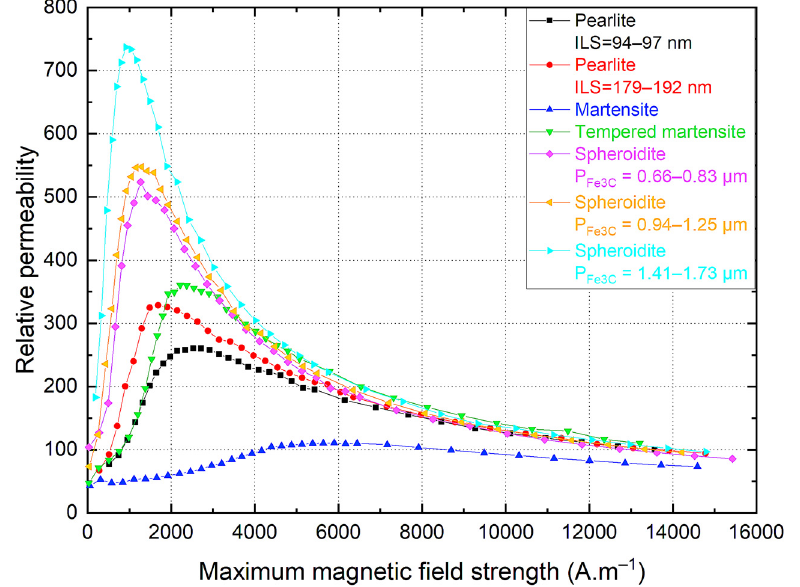
Figure 11. Relative permeability in the function of the maximum magnetic field strength obtained for the eutectoid steels of group C.